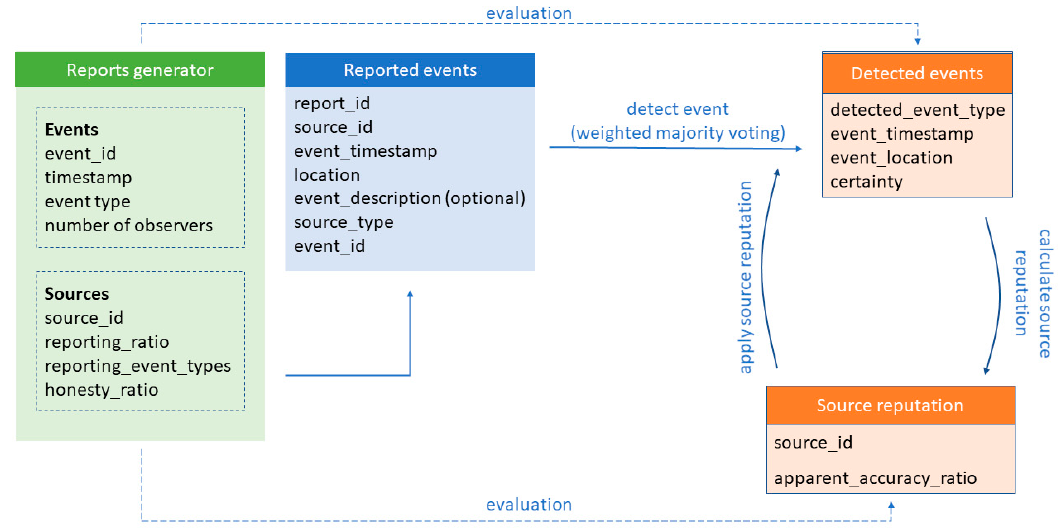
Figure 2. Event reporting and detection, and source reputation assessment data model.